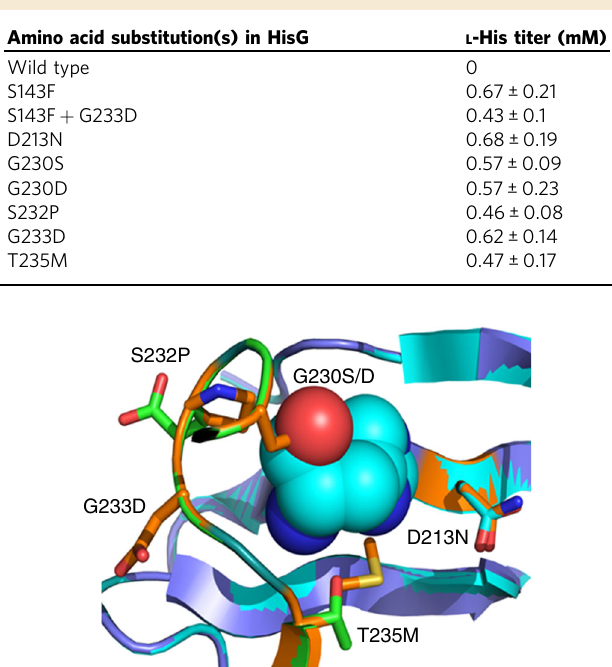
Table 2 Amino acid substitutions in HisG and determined L -histidine